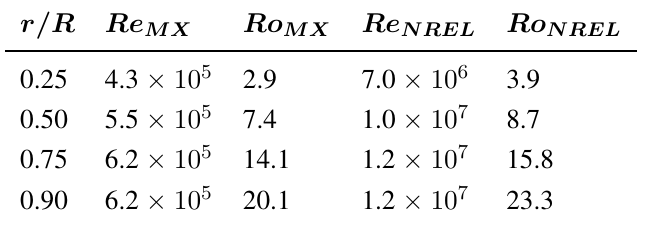
Table 2. Reynolds and Rossby numbers for the MEXICO (subscript MX) and the National Renewable Energy Laboratory (NREL) 5 MW (subscript NREL) wind turbines at different radial